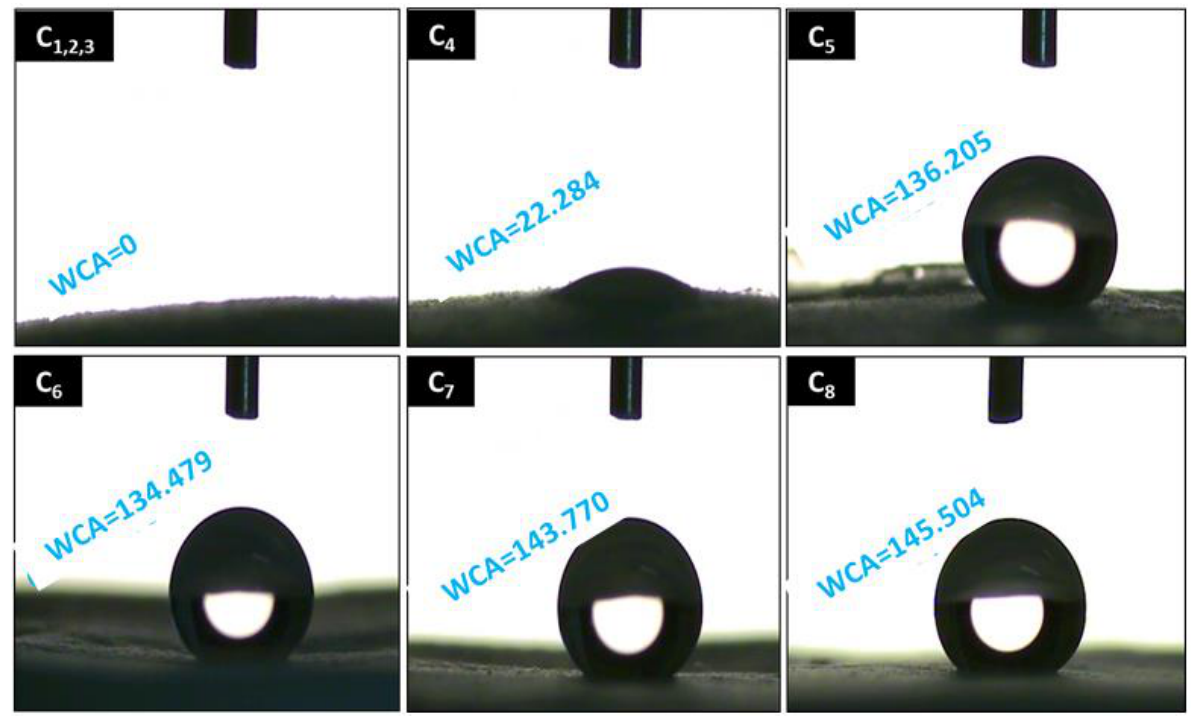
Figure 5. WCA of the unmodified and modified CNC aerogels.